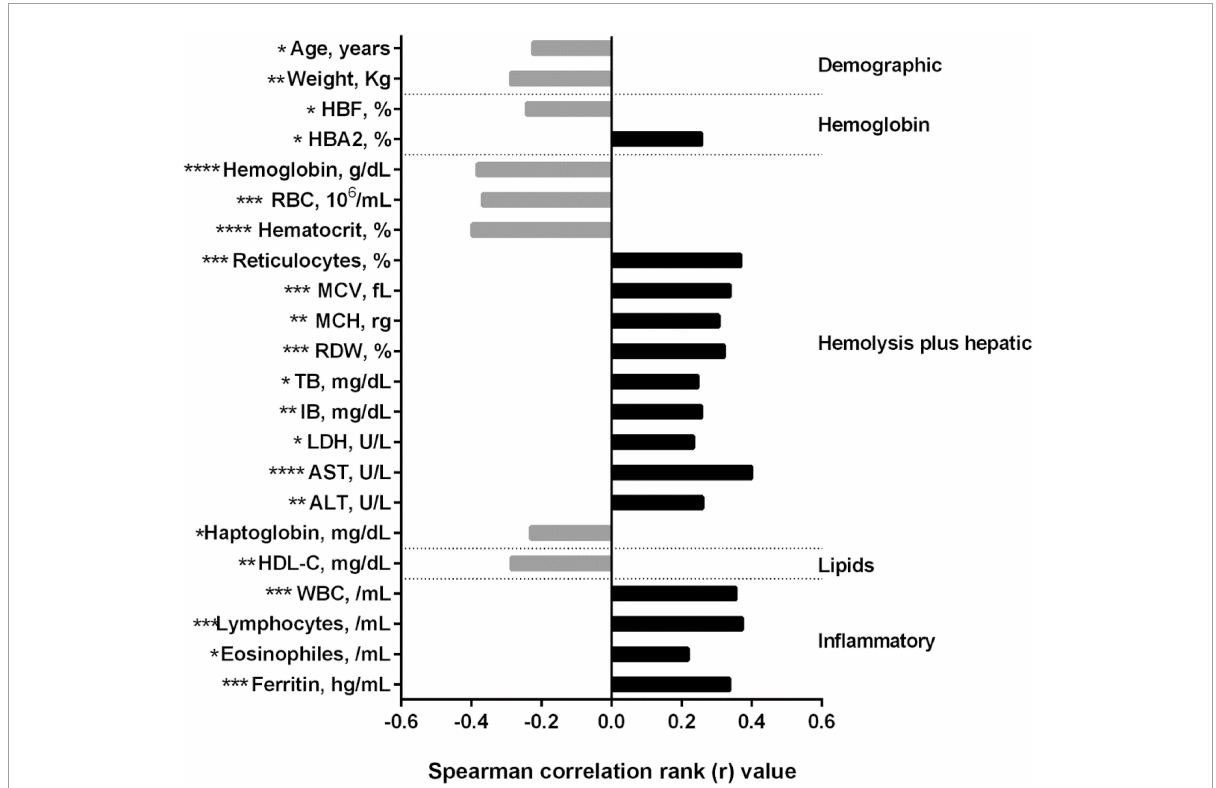
FIGURE2 Correlations between TAMMV and laboratory markers in SCA children. Data were obtained using the Spearman correlation rank test. Bars represent the strength of correlation (r values). Gray and black bars indicate a negative and positive correlation, respectively. TAMMV, time-averaged maximum mean velocity; HBF, Fetal hemoglobin; HBA2, normal hemoglobin A2; RBC, red blood cells; MCV, mean corpuscular volume; MCH, mean corpuscular hemoglobin; RDW, red cell distribution width; TB, total bilirubin; IB, indirect bilirubin; LDH, lactate dehydrogenase; AST, aspartate aminotransferase; ALT, alanine aminotransferase; HDL-C, high-density lipoprotein cholesterol; WBC, white blood cells. * p < 0.05, ** p < 0.01, *** p < 0.001 and **** p <